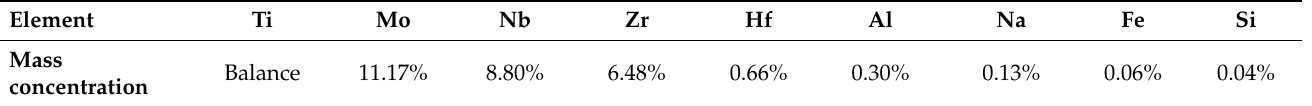
Table 1. The chemical composition of Ti-Mo-Nb-Zr produced